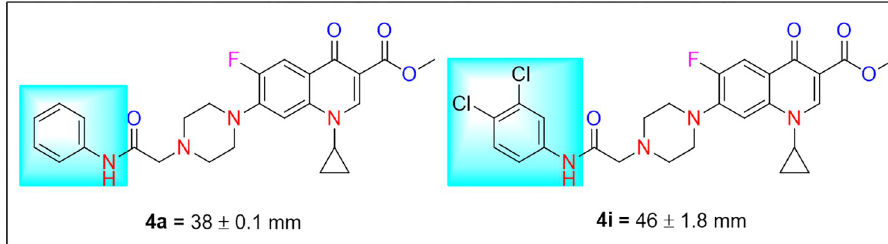
Fig 4. Structures of compounds 4a and 4i active against Escherichia coli .